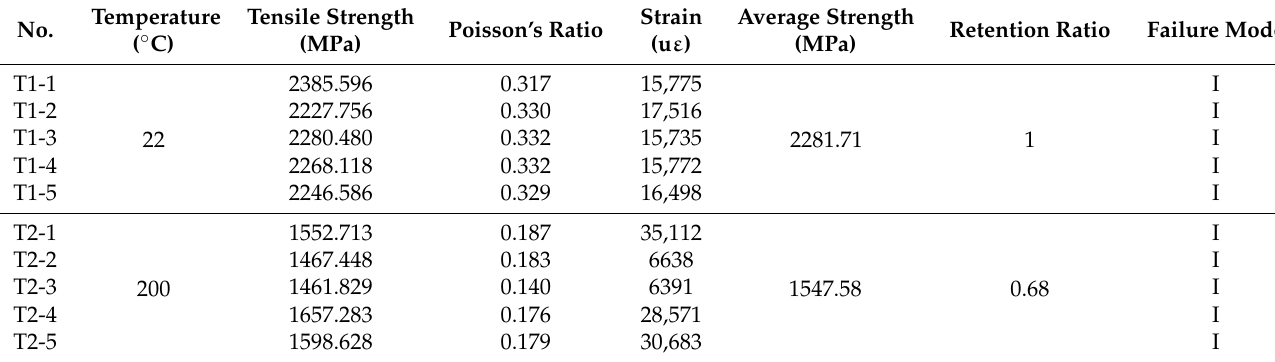
Table 3. Test results of the tensile strength of unidirectional CFRP plate